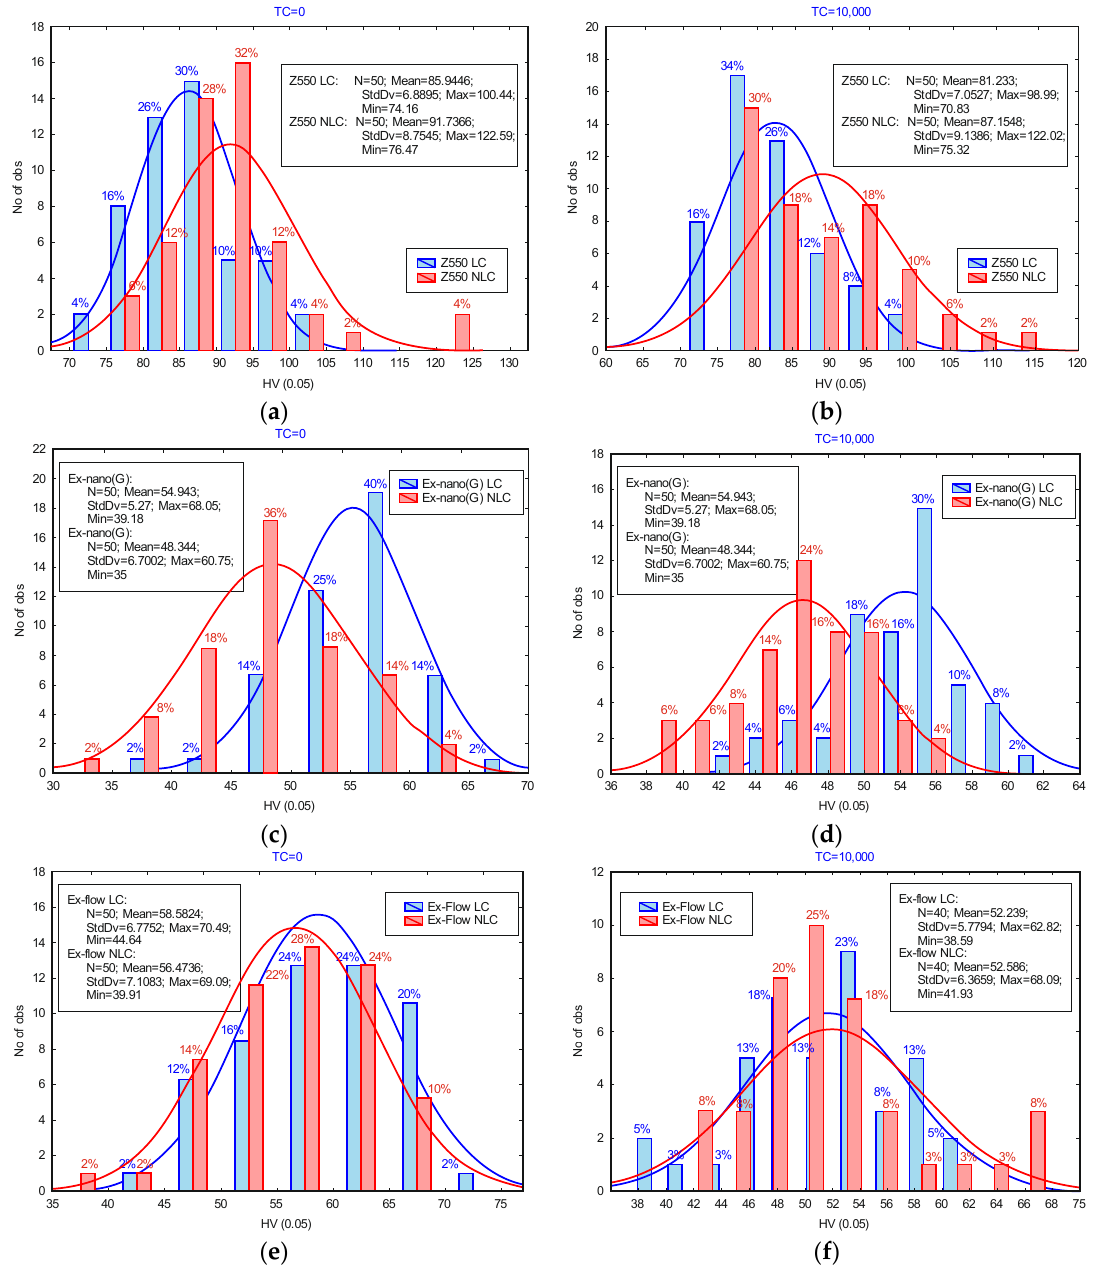
Figure 3. Frequency distributions of microhardness test results for: ( a ) Z550, ( b ) Z550 after thermal fatigue, ( c ) Ex-nano (G), ( d ) Ex-nano (G) after thermal fatigue, (e ) Ex-flow (G), and ( f ) Ex-flow (G)